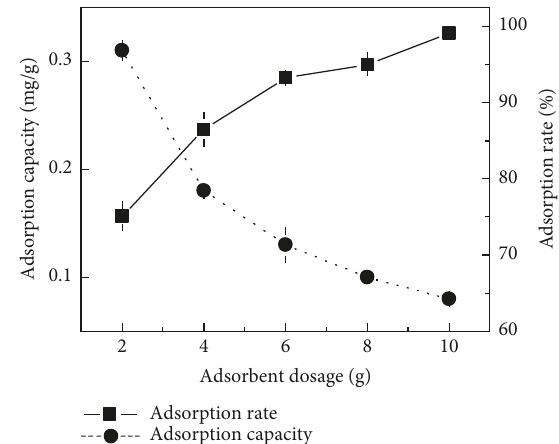
Figure 5: Effect of adsorbent dosage on adsorption capacity and adsorption